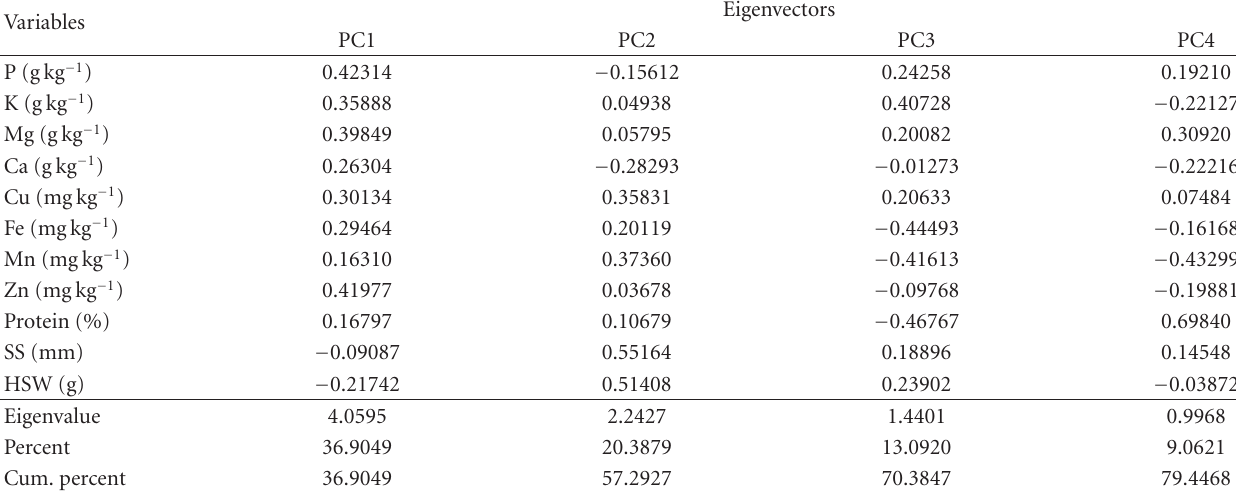
Table 4: Eigenvectors, eigenvalues, individual and cumulative percentages of variation explained by the first four principal components (PC) of 39 Turkish lentil landraces and 7